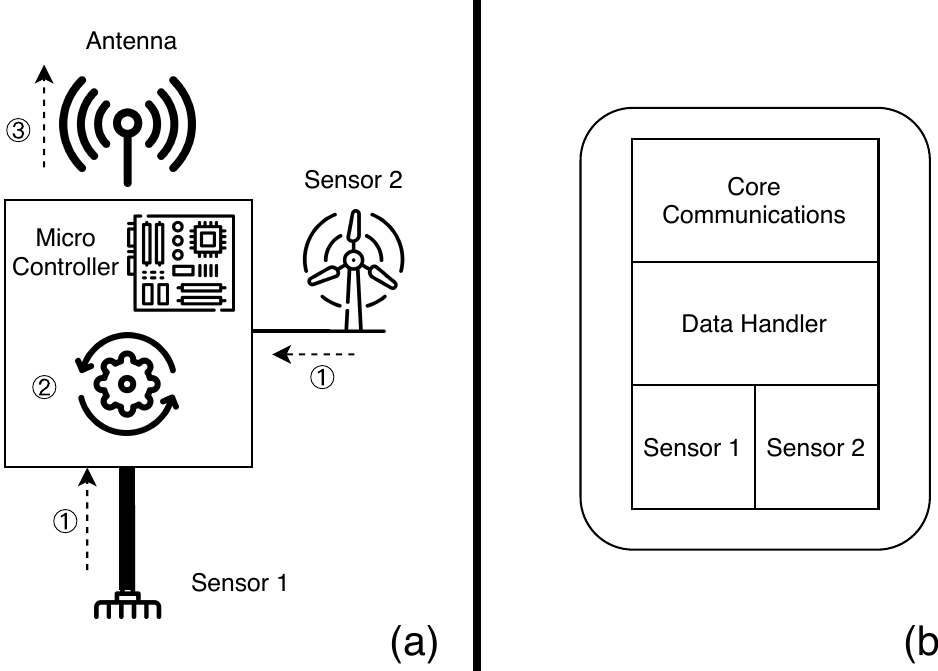
Figure 10. Implementation of the monitoring subsystem: ( a ) A conceptual model of a monitoring module. These data are first read from sensors monitoring a phenomenon; after that, they are internally processed in the microcontroller and finally transmitted to the point of interest. ( b ) How this module can be implemented using our framework: by using the predefined modules, fewer than 20 lines of code are needed to obtain a working system with many advantages, such as error detection, data smoothing, transformation, and